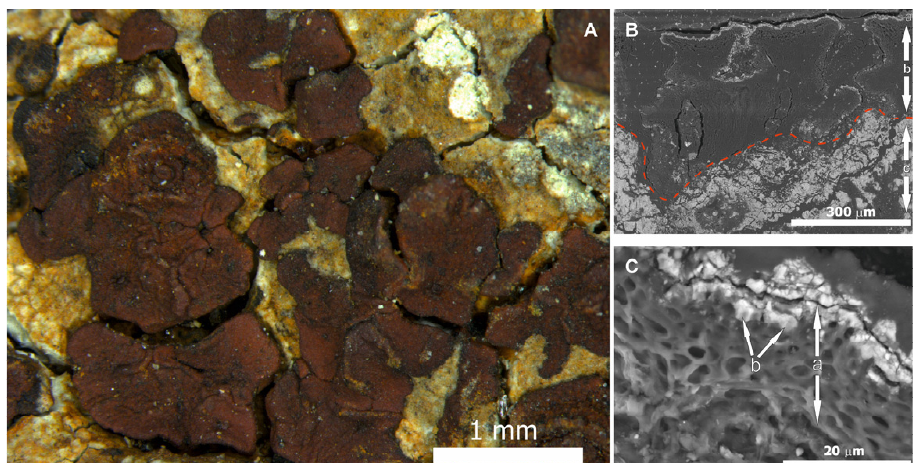
Figure 5. Incrustation of mycobiont hyphae with microgranules of iron hydroxide in the cortex of the lichen Acarospora sinopica on the surface of pyrrhotite rock (Pyrrhotite Gorge deposit, Khibiny mountains, Kola Peninsula): A —squamules of Acarospora sinopica lichen thallus; B —section through pyrrhotite bedrock ( c ) and lichen thallus Acarospora sinopica ( b ); C —lichen cortex ( a ) with microgranules of iron hydroxide of goethite ( b ).